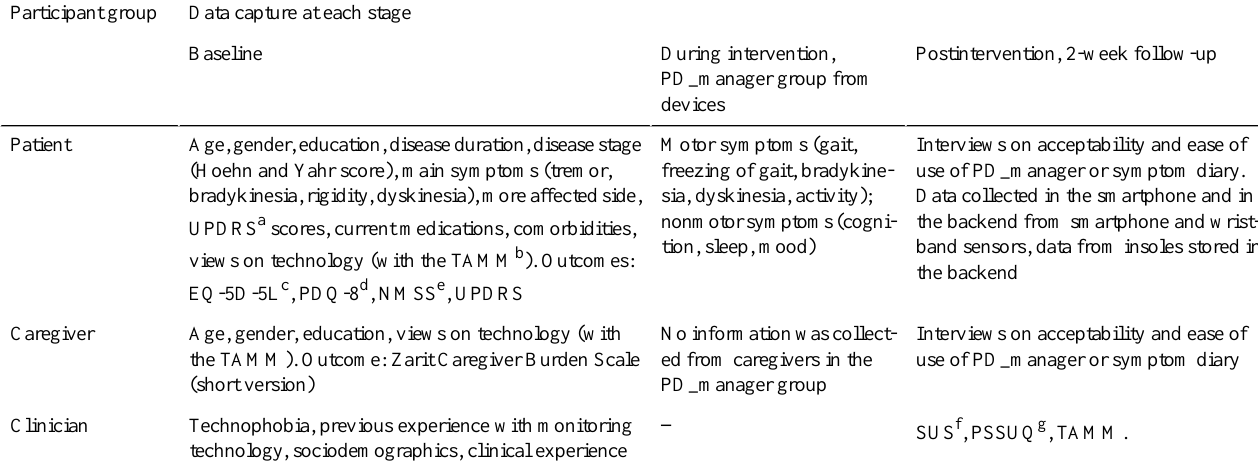
Table 2. Summary of PD_manager group data collection at each stage. Data capture at each stageParticipant